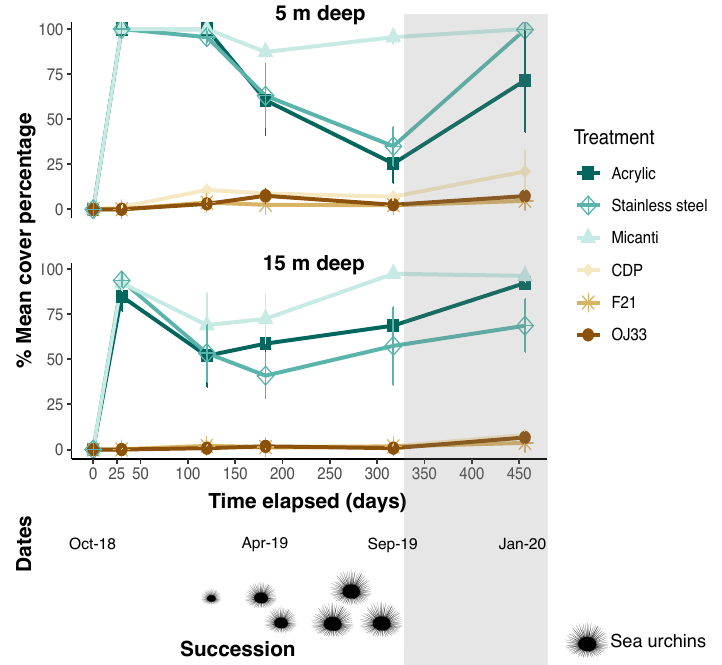
Figure 5. Mean cover percentage (% ± SE) in the 100 cm 2 plates recorded during 15 months at the two depths of deployment. Biofilms cover data was removed. The shade represents biomass accumulation rates post-sea urchin